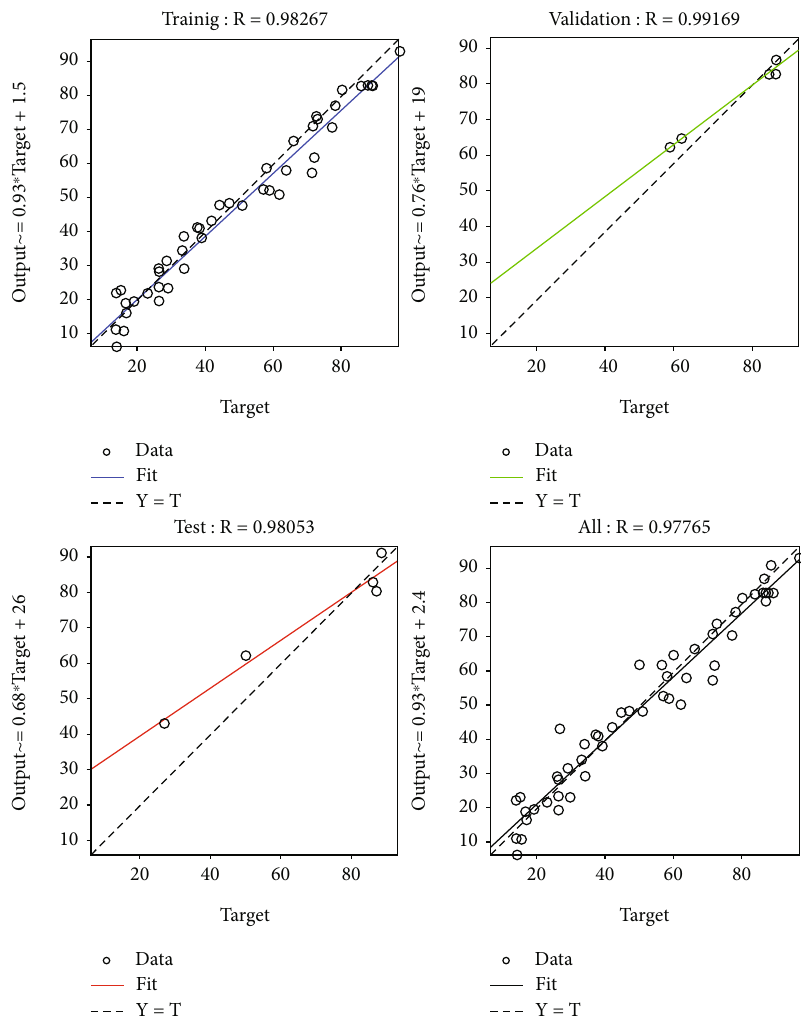
Figure 10: Regression plot for CEX onto Fe